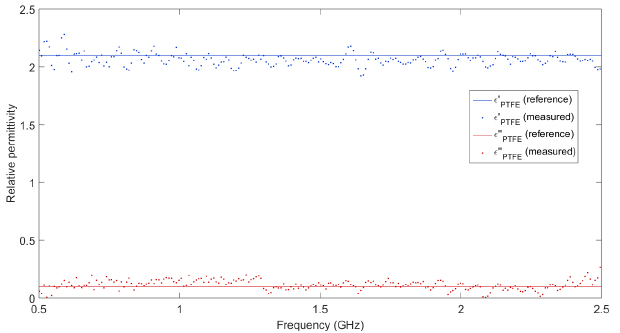
Figure 6. Real ( ε (cid:48) ) and imaginary ( ε (cid:48)(cid:48) ) relative permittivity PTFE PTFE (unitless) of a block of polytetrafluoroethylene (PTFE).